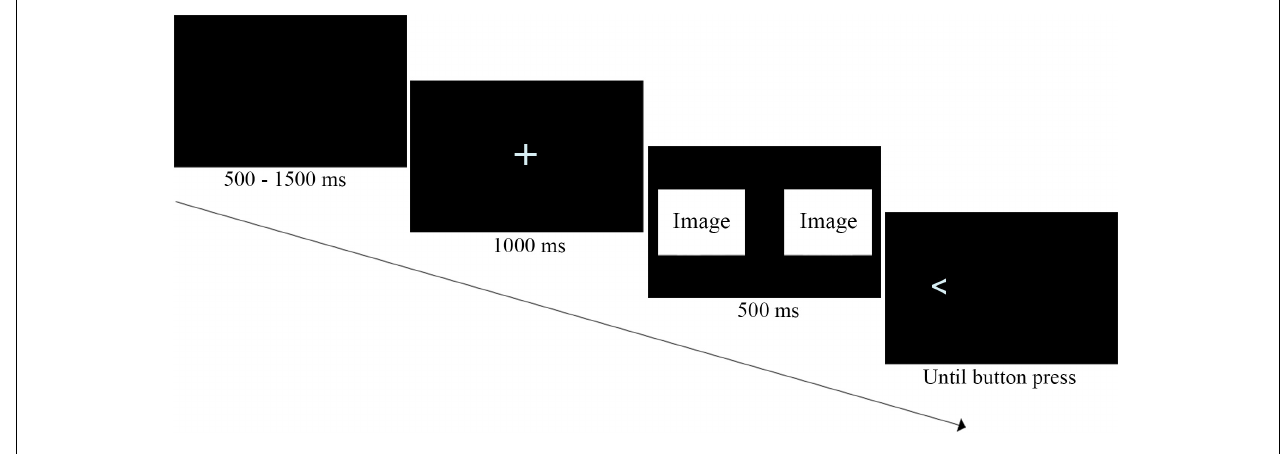
FIGURE 1 | Modified dot-probe task